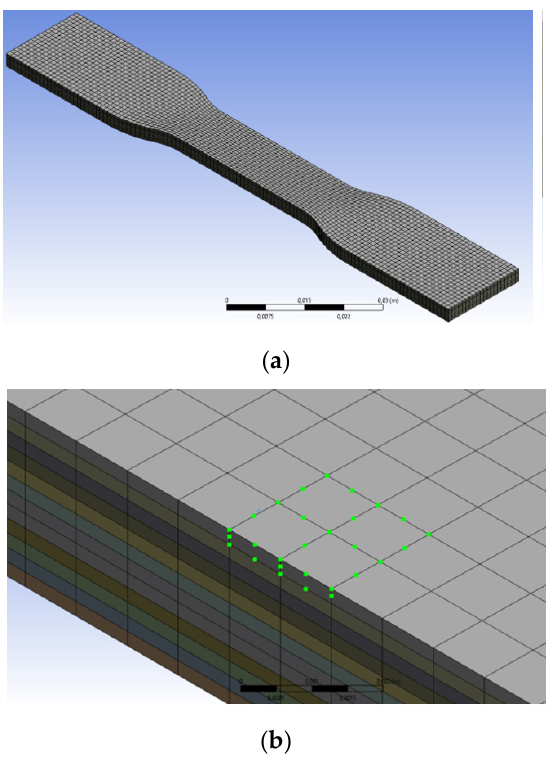
Figure 3. ( a ) General mesh of a body. ( b ) Second-order elements.